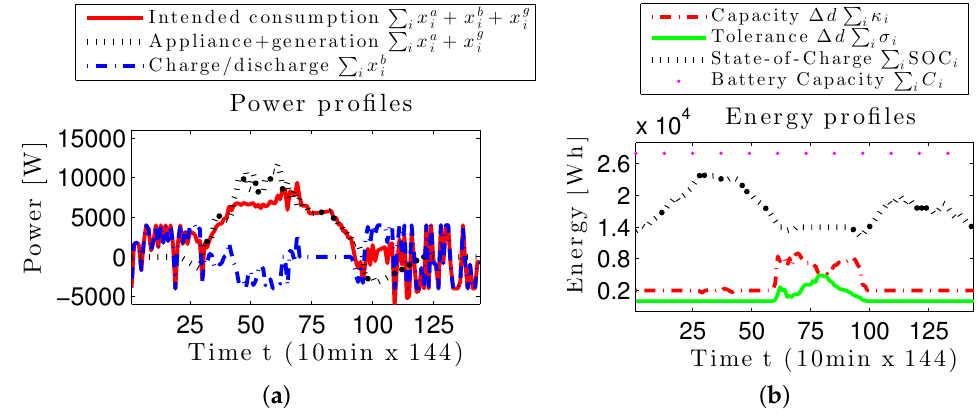
Figure 11. Augmented day-ahead coordination results. ( a ) Intended consumption, appliance + generation, and battery (dis)charge. The coordination obtains an intended consumption with a peak below 10 kW (DR obtains a peak in the range [20,36] kW; see Figure 10); ( b ) The capacity is always larger than the tolerance, and complements the state-of-charge (SOC). The capacity and tolerance are shown in Wh (by multiplying them by ∆ d